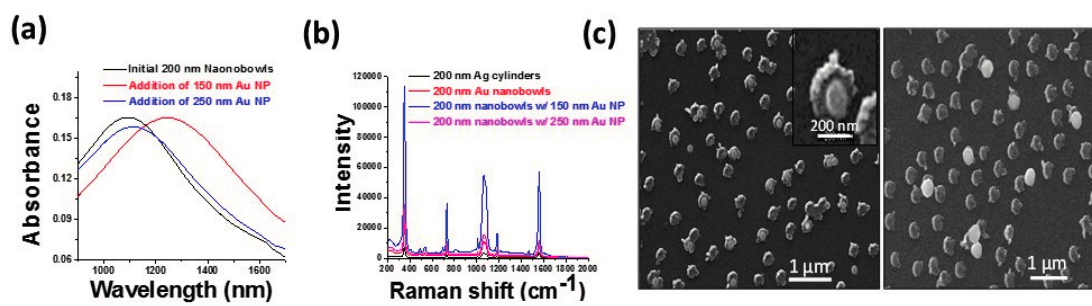
Figure 4. Size-selective sensing of colloidal nanoparticles with 200 nm Au-Ag nanobowl arrays. For nanoparticles small enough to fit into the nanobowls, a large increase in LSPR shift, ( a ) and SERS intensity; ( b ) is observed; ( c ) Scanning electron microscopy